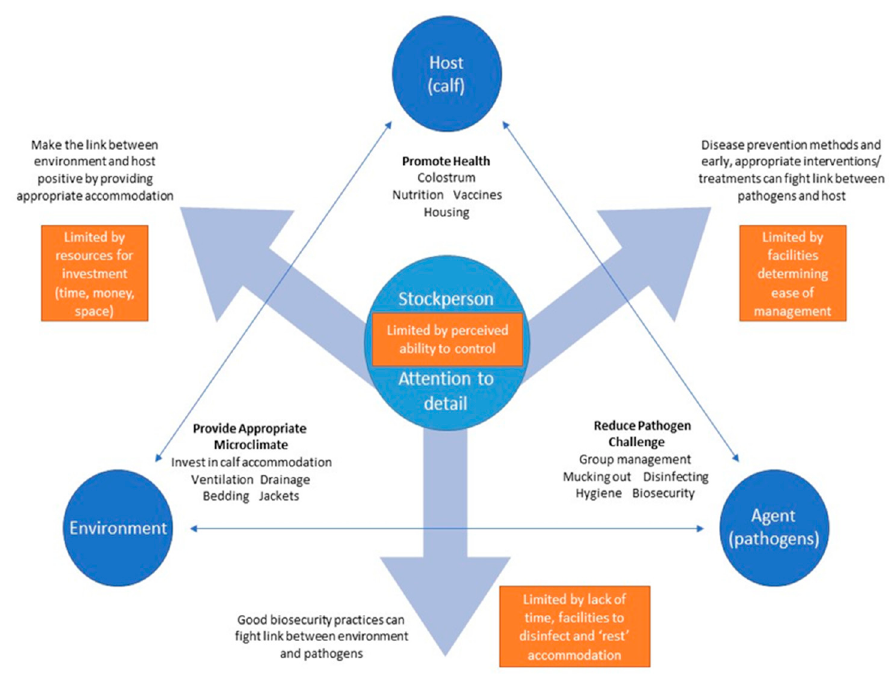
Figure 1. Schematic demonstrating the human dimension of the epidemiological triad. Perceived Control over Disease Processes